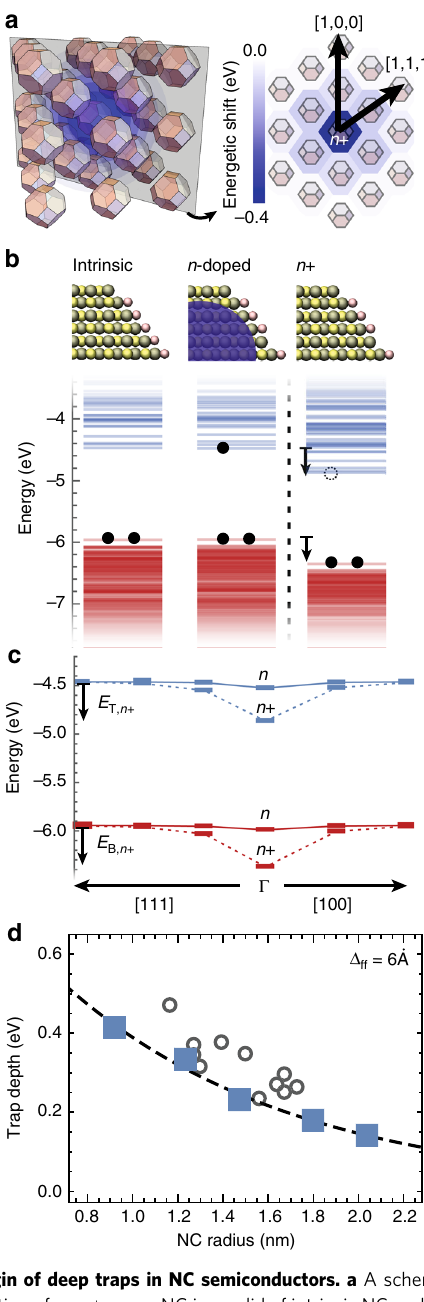
Fig. 2 Origin of deep traps in NC semiconductors. a A schematic representation of an n + or p − NC in a solid of intrinsic NCs, where the shift in the energy structure will be screened by neighboring NCs, and a contour plot of the energy shifts of the lowest unoccupied electronic level in NCs ( r = 0.95 nm with Δ ff = 0.6 Å) for an n + NC in an NC solid. b Electronic structure of intrinsic, n -doped, and oxidized n -doped NC ( n + ). c Highest occupied electronic levels (red) and lowest unoccupied electronic levels (blue) of an n , n + NC at the Γ point in the BCC lattice and its intrinsic neighbors in the [111] and [100] directions in an NC solid. d Trap depth as a function of NC size for NCs in vacuum (circles) and for NC solids (squares). Experimentally measured trap depths on PbS NC solids 23,28 (gray circles) and the NC charging energies calculated for a sphere of radius r in a PbS NC solid (dashed gray line) (see Supplementary Information Note 5)